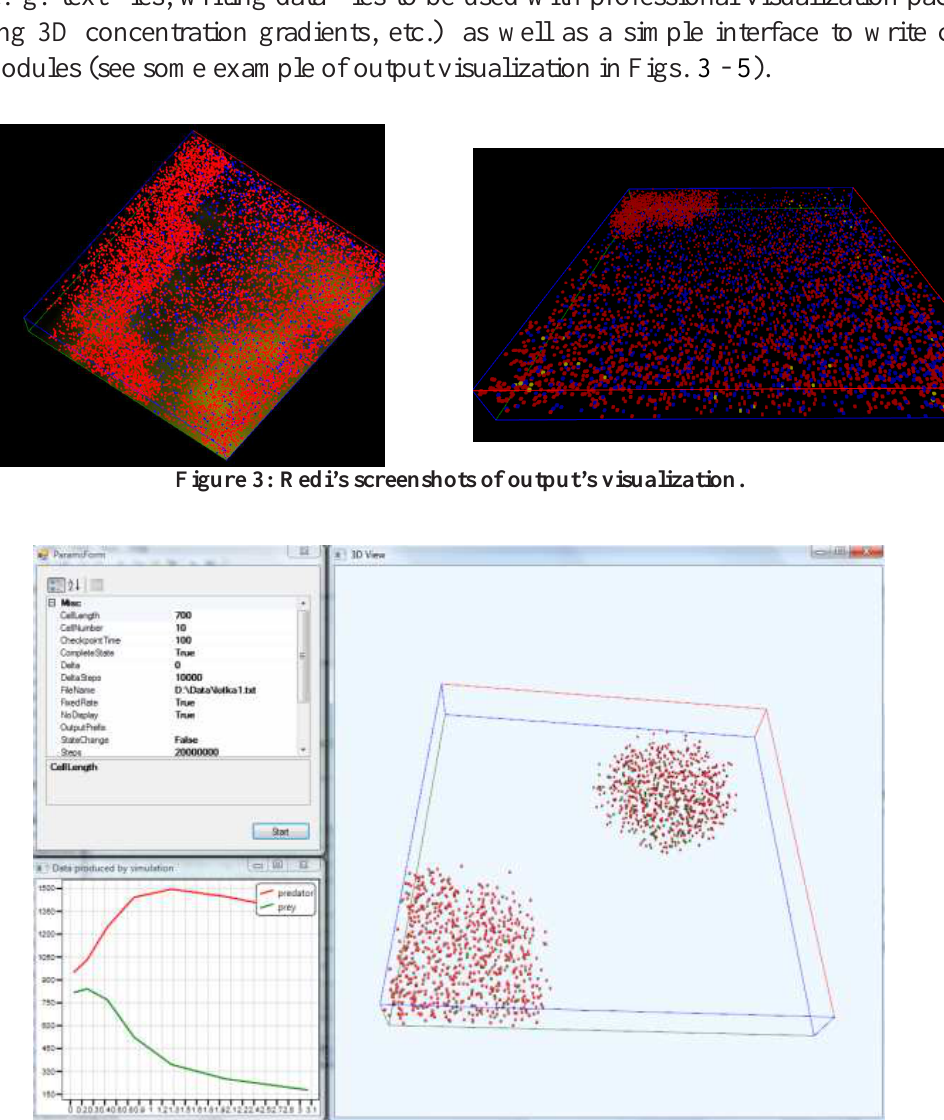
y sc atter-plot of the time behavior of average con- Figure 4: Visualization of Redi outputs: x − centrations of species in the system (left lower corner) and 3D visualization of the concentration gradient at a certain step of simulation (on the right). The menu on the right upper corner lists the parameters of the simulation that are tunable by the user, such as the number of sub-volumes, their size, the number of steps of the simulation